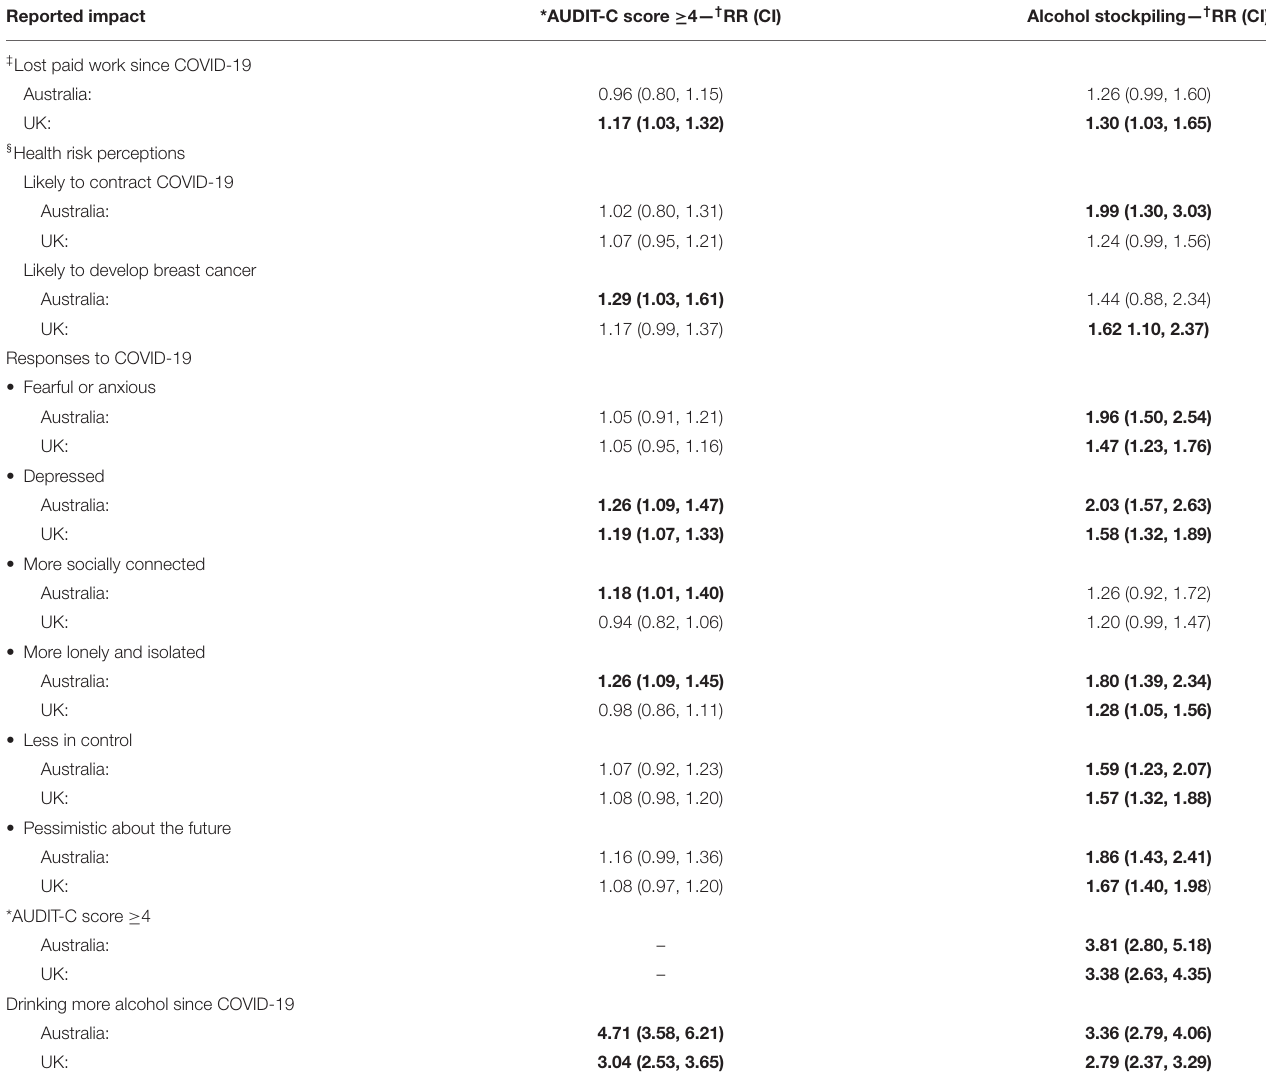
TABLE 2 | COVID-19 impacts at entry, problematic drinking, and alcohol stockpiling ( N = 2,437). Reported